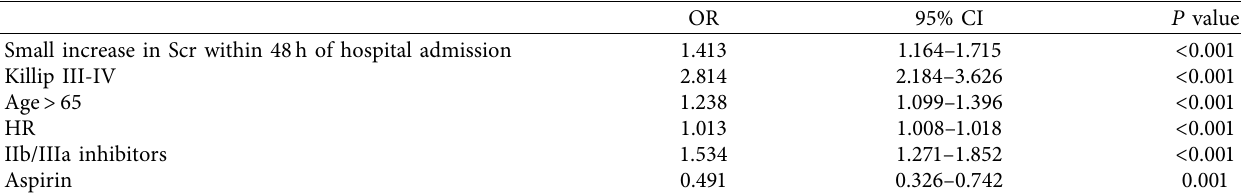
Table 4: Primary analysis: risk factors for massive hemorrhage in patients with STEMI who underwent primary PCI. OR 95% CI P